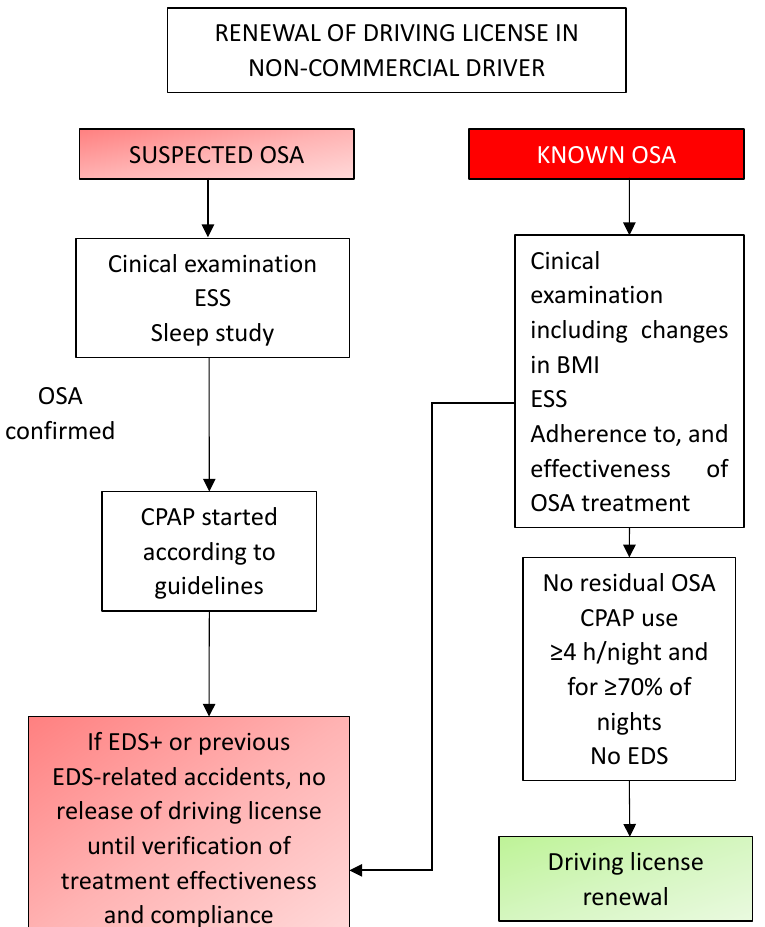
Figure 2. Proposed flowchart to be used for driving license release or renewal. Patients with suspected obstructive sleep apnea (OSA) should be studied and treated whenever the diagnosis of OSA is confirmed. In both newly diagnosed or already known OSA patients, driving licenses should be released or renewed only after the objective documentation of satisfactory compliance with treat-